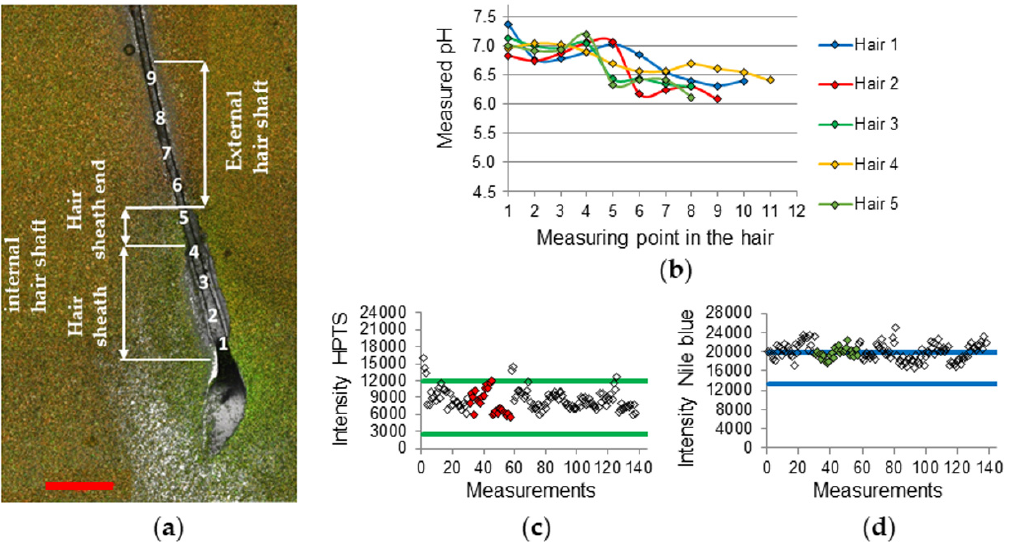
Figure 3. ( a ) CLSM fluorescence overlay of HPTS (green) and Nile blue (red) emission and transmission channels (subject 6, hair 2). Measurement points 1–9. Scale bar: 500 µm. ( b ) pH gradients of the different hairs from subject 6, measurement starts at the hair sheath (points 1–4), then at the infundibulum region (point 5) and ends at the external hair shaft (points 6–9). HPTS emission intensity raw data points of all hair measurements (hair 2 data points are filled) of subject 6 ( c ), Nile blue emission intensity raw data points of all hair measurements (hair 2 data points are filled) of subject 6 ( d ).